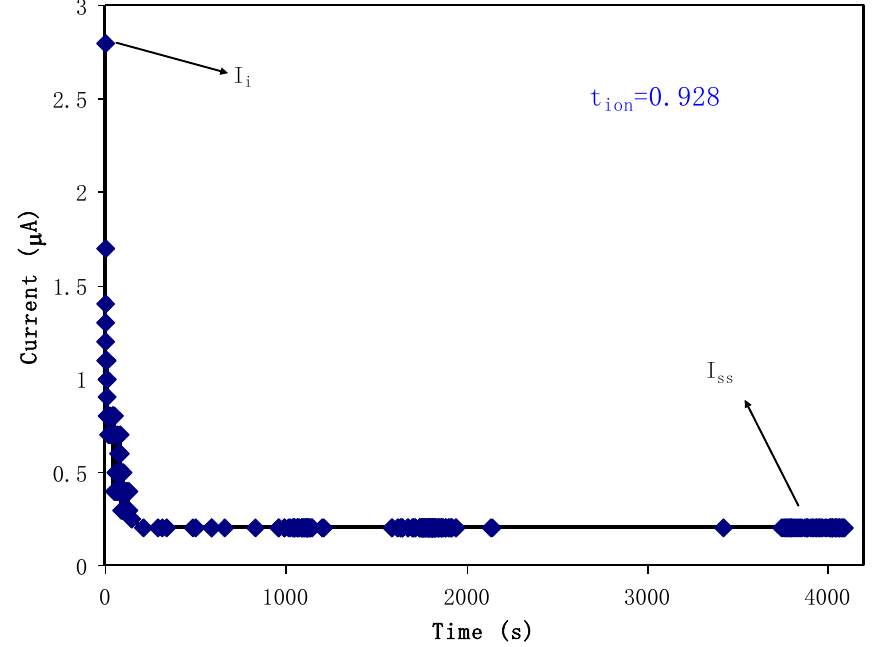
Figure 7. Polarization current versus time for the highest conducting CS: Dextran: NH 4 I electrolyte.